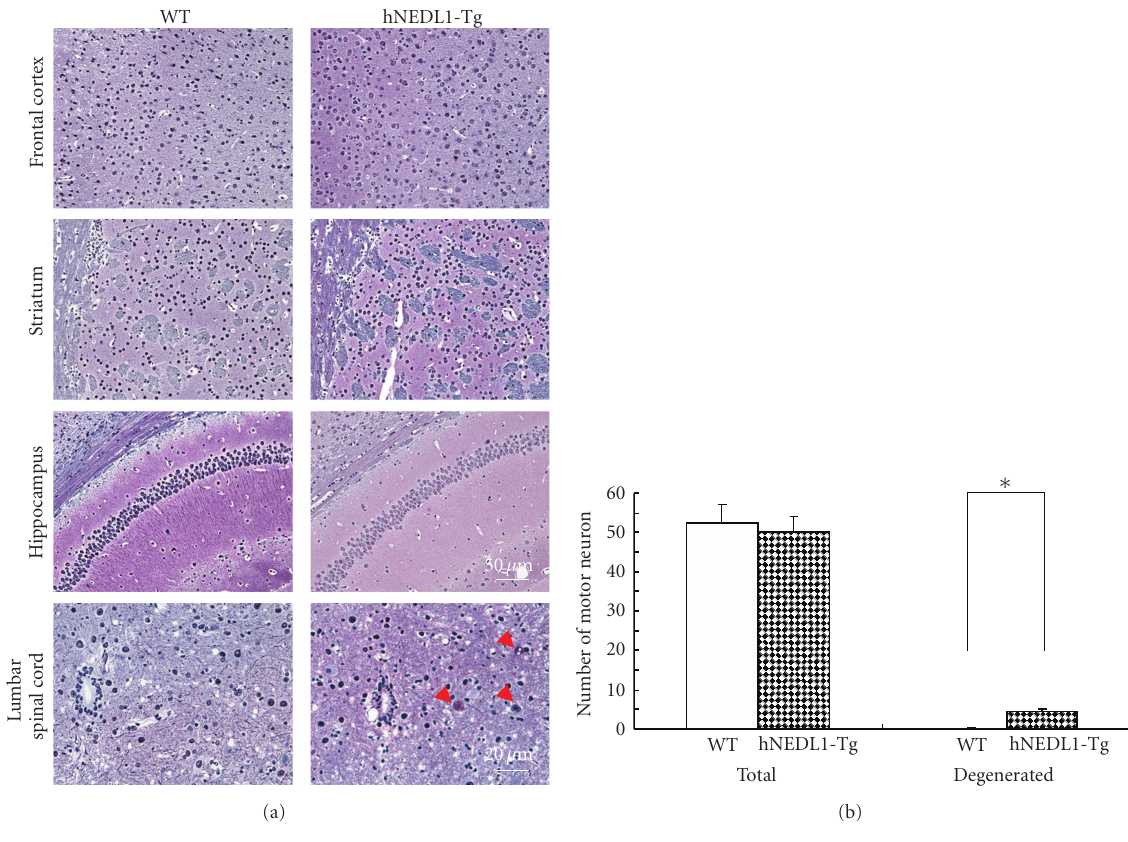
Figure 4: Overexpression of hNEDL1 induced neuron degeneration in lumbar spinal cord and skeletal muscle atrophy . Bodian -stained section of frontal cortex, hippocampus, striatum (bar = 50 μ m), and lumbar spinal cord (bar = 20 μ m). Degenerated motor neurons and decreased axon are observed in the lumbar spinal cord in the hNEDL1-Tg mouse. The numbers of motor neuron in the total motor neuron and in the degenerated motor neuron from wild-type mice (white bar: n = 12) and hNEDL1-Tg mice (black bar: n = 11) from the age of six to fifteen months were shown. Data are mean ± SEM ( ∗ P < .